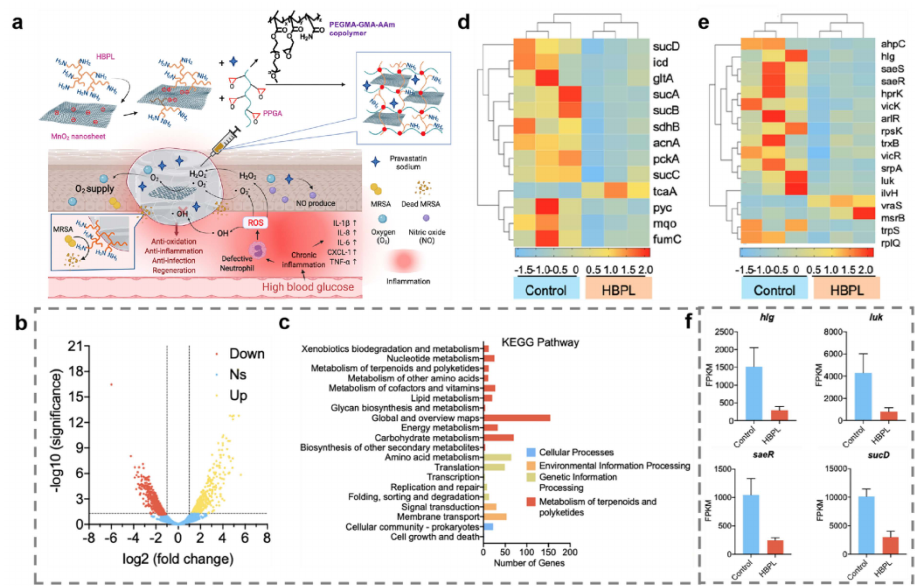
Figure 7. Disruption of bacterial nucleic acids by hyperbranched poly-L-lysine (HBPL)-crosslinked hydrogel containing MnO 2 . ( a ) Antibacterial and wound healing promoting mechanism of HBPL- crosslinked hydrogel containing MnO 2 . ( b ) Volcano plot analyses of total Differentially expressed gene. ( c ) KEGG analyses of DEGs. Heatmap of genes associated with tricarboxylic acid cycle (TCA)